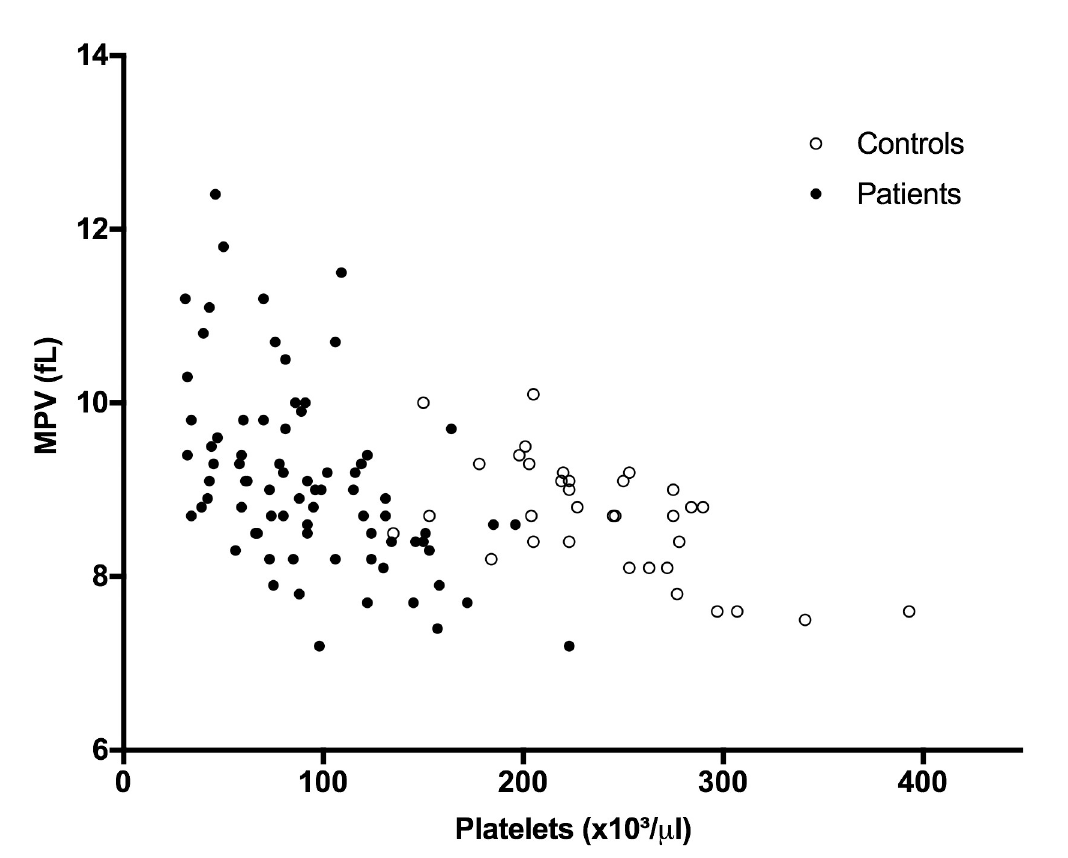
Fig 1. Platelet counts and volume. Platelet count and MPV were inversely correlated in both patients and controls (N: 77 patients and 34 controls). Patients: R = -0.5216, P < 0.0001; Controls: R = -0.5808; P < 0.001. The blood counter could not determine the MPV for two of the 79